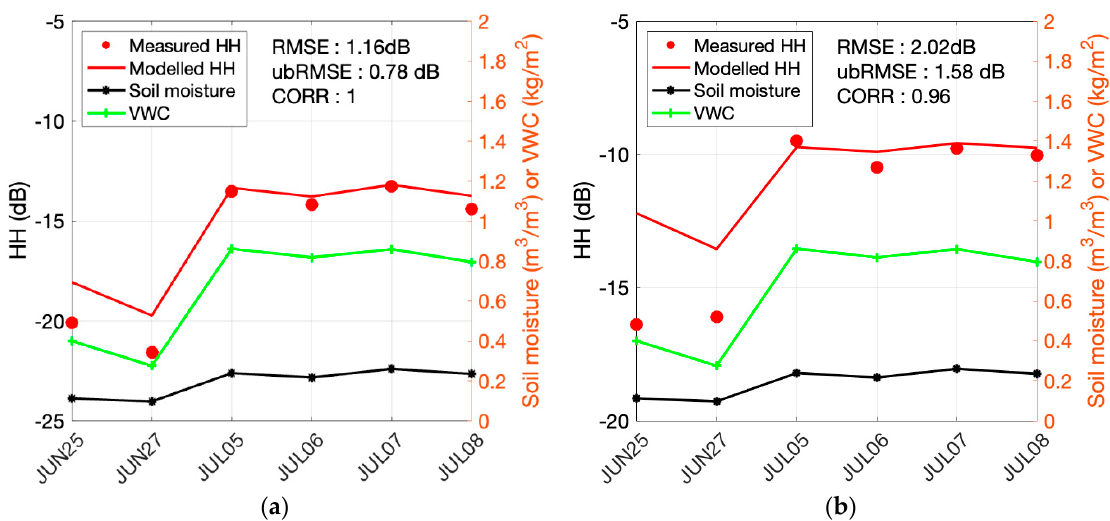
Figure 6. Forward model comparison of soybean field at site 10 (rms height: 1.08 cm) ( a ) L-HH ( b ) S-HH.